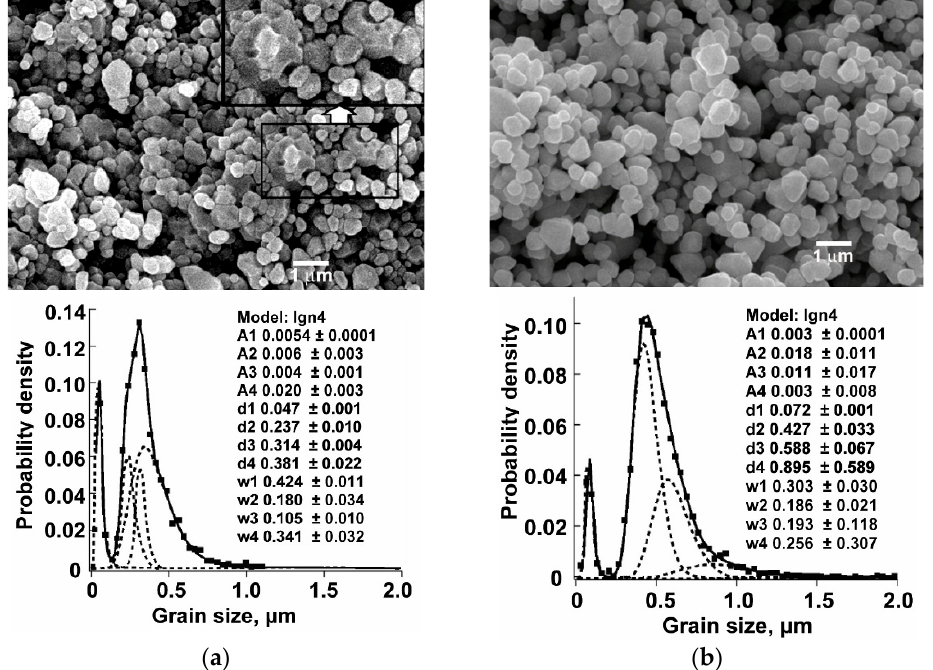
Figure 5. Grain size distribution of the ZnO film deposited on ( a ) Al with D = 0.320 ± 0.004 μ m and ( b ) Cu with D = 0.5 ± 0.005 μ m conductive sub-layers measured with SEM. D is the averaged value of the grains.